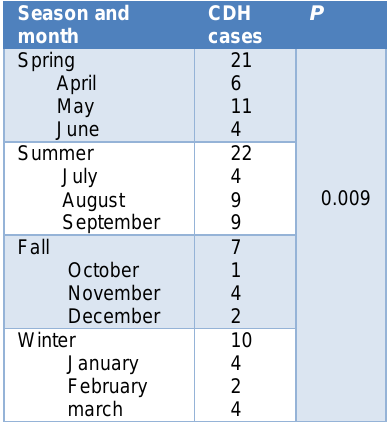
Table 2. The effect of season and month of last menstrual period on the prevalence of CDH.